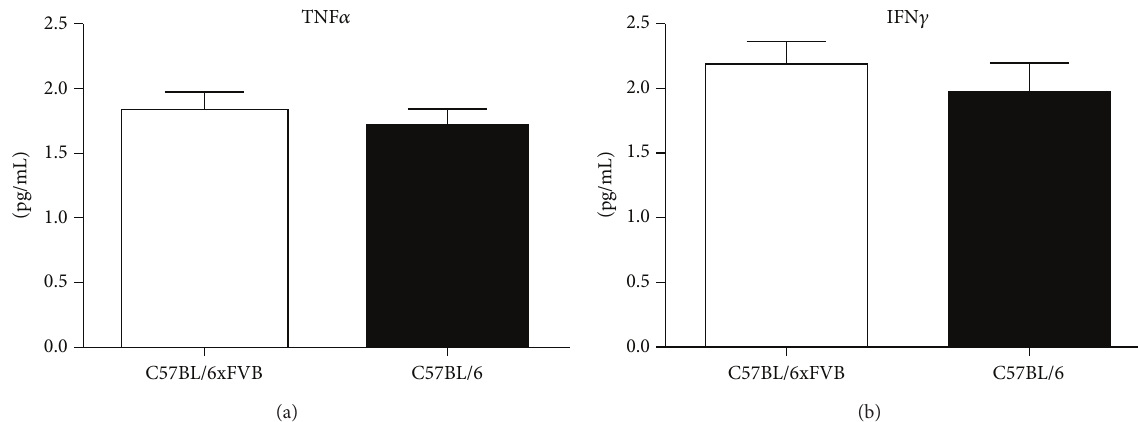
Figure 2: Concentrations of proinflammatory cytokines in serum. Concentrations of TNF 𝛼 and INF 𝛾 did not differ between C57BL/6JxFVB and C57BL/6J